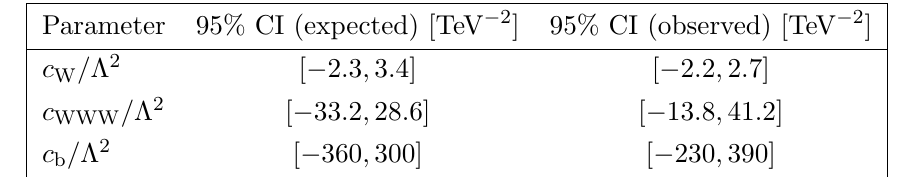
Table 13 . Expected and observed one-dimensional con(cid:12)dence intervals (CI) at 95% con(cid:12)dence level for each of the considered EFT parameters. Both the square matrix of the dimension-6 contribution and the interference term between the SM amplitude and the BSM one are accounted for. The one- dimensional intervals for each parameter are computed (cid:12)xing the other two parameters to zero, the SM value.